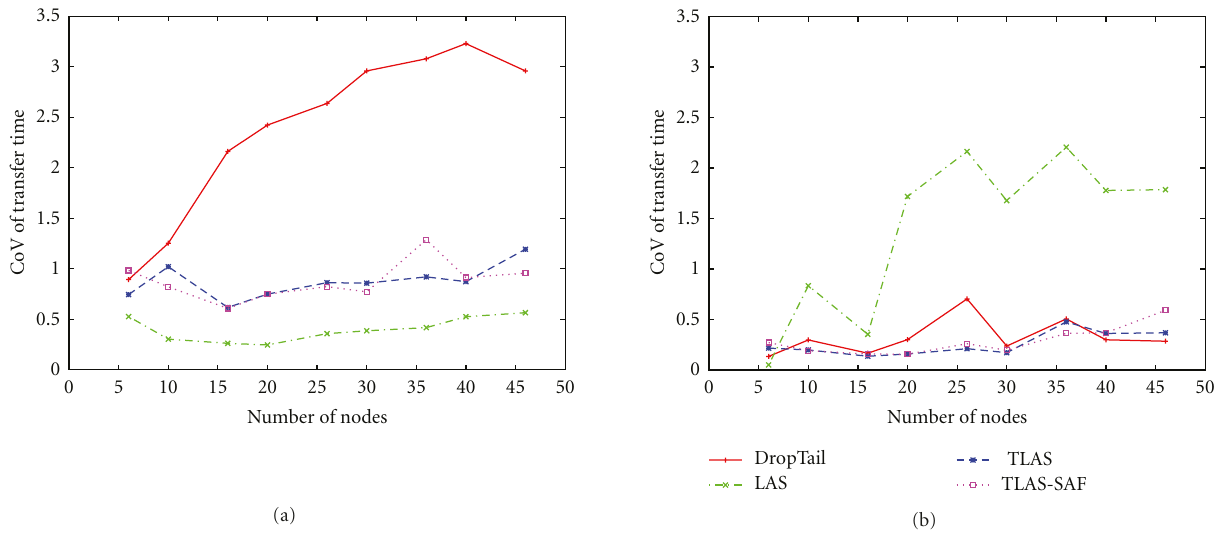
Figure 4: CoV of transfer time under DropTail/FIFO (short flows interarrival time = 500 ms): (a) small files; (b) large files.